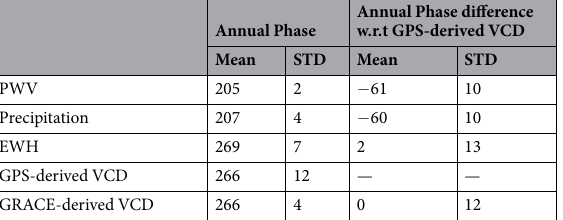
Table 1. Statistics of annual phase of PWV, precipitation, EWH, and GPS-derived and GRACE-derived VCD and their difference with respect to GPS-derived VCD. All these quantities are in days. The annual phase is the day of year when an annual signal reaches its